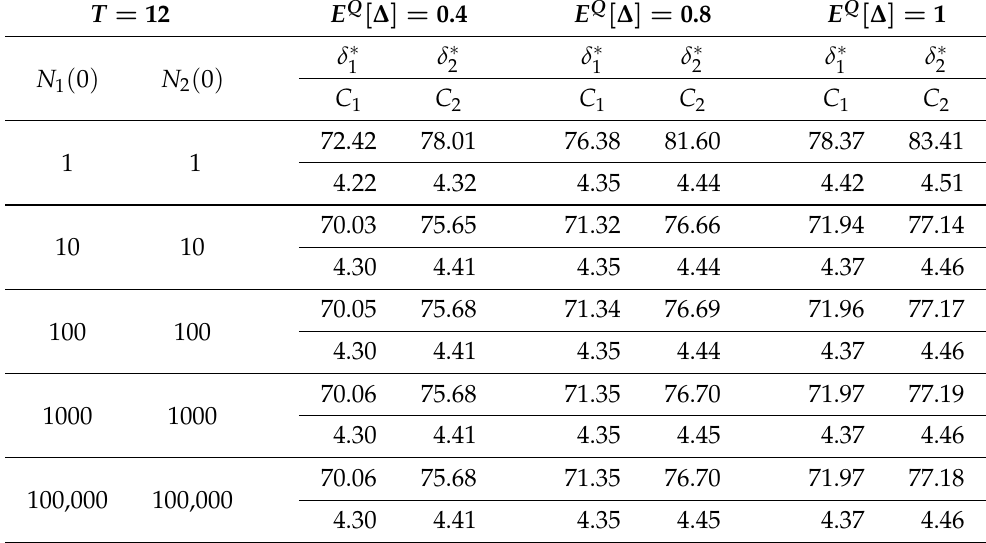
life table IPS55 in use in the Italian annuity market, see Bacinello et al. (2018). Further,